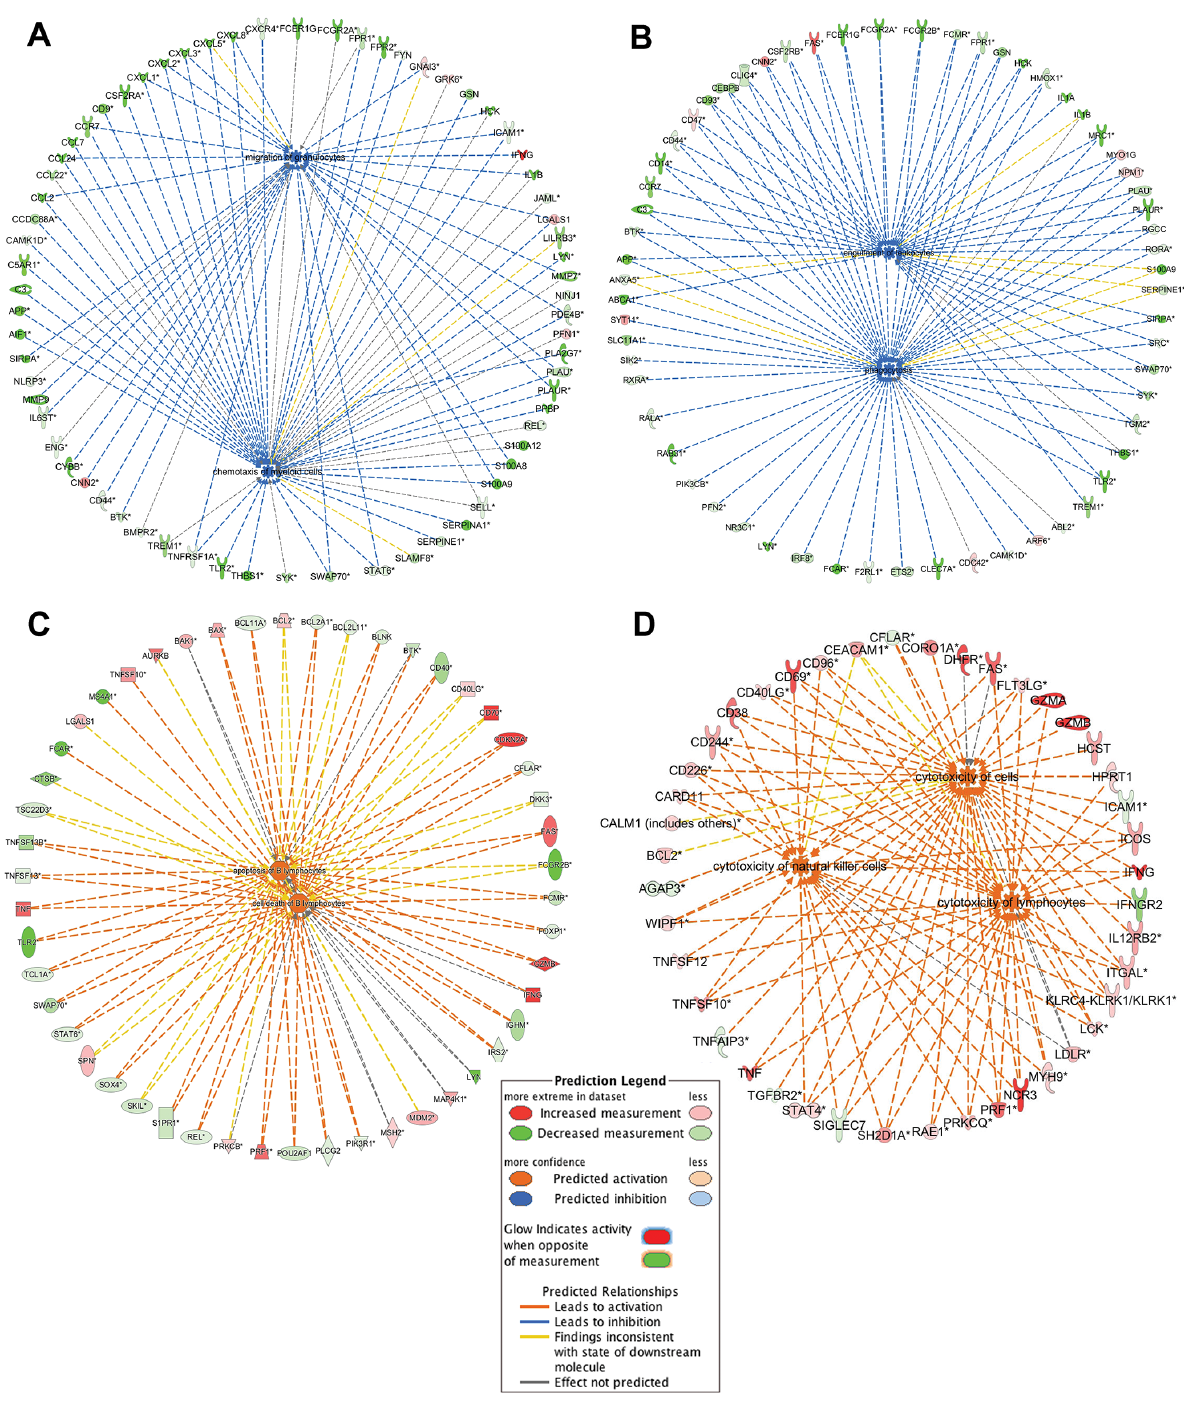
Figure 6. IPA functional analysis of gene expression data from CIK cells discovered different inhibited/activated processes based on the expression pattern of regulatory molecules: (A) chemotaxis, (B) phagocytosis, (C) apoptosis of B lymphocyte, (D) cytotoxicity. The orange lines show that the activation effect of protein was positively confirmed by the IPA Knowledge database. The blue lines show that the inhibitory effect of protein was positively confirmed by the IPA Knowledge database. The gray lines indicate that the proteins lacked literature support to predict the activation effect. The yellow lines indicate that our results and the literature in IPA are not consistent. Solid lines: direct interactions; dashed lines: indirect